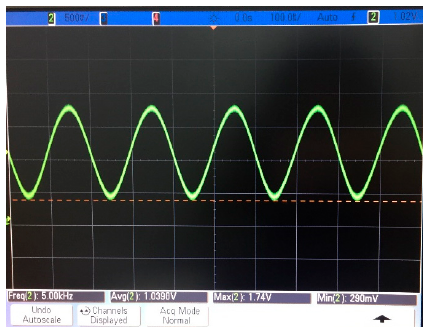
Figure 5. Waveform of the modulation light.